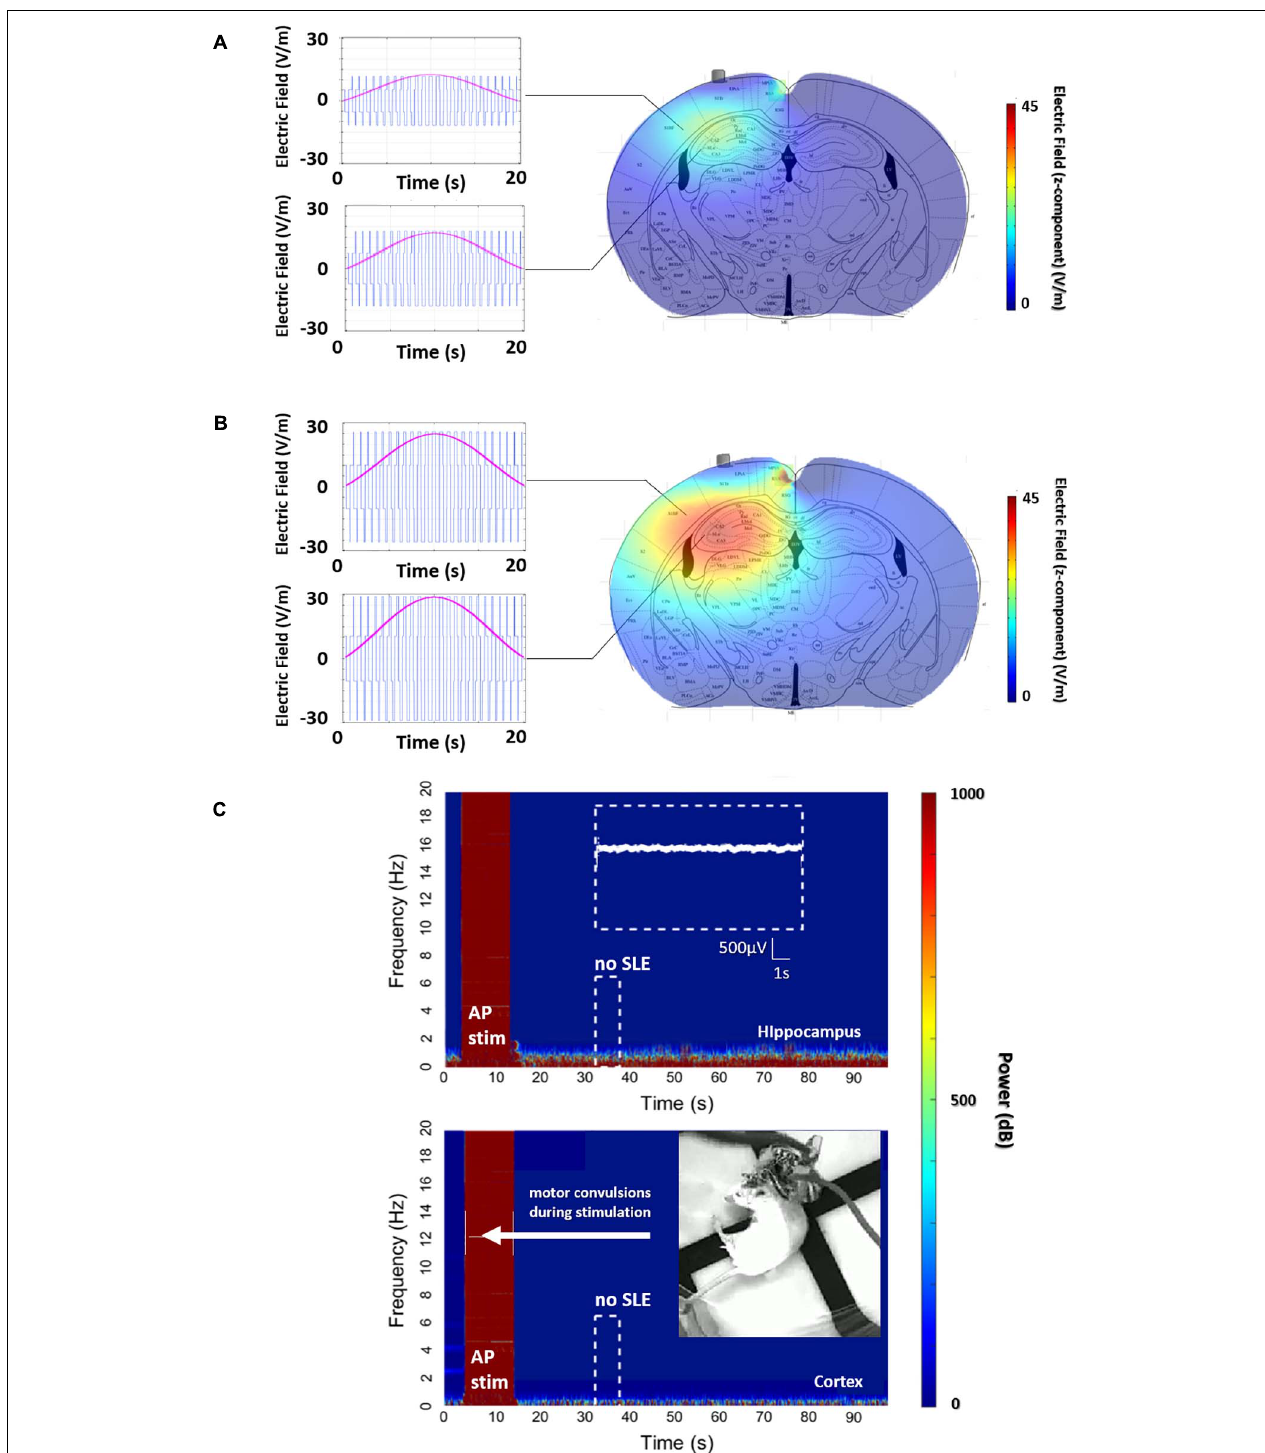
FIGURE 3 | AP, non-preferential orientation, electric field envelope versus anatomy. (A) Profile of the electric field and envelope for the stimulation in Figure 2D (600 µ A per pair), and (B) stimulation with the same orientation but with a higher stimulation amplitude (1500 µ A per pair). Clearly, continuously increasing the intensity of stimulation will increase the envelope of stimulation in the hippocampus, ideally leading to an SLE. However, the increase in stimulation amplitude creates a non-trivial increase of the envelope located in the cortex. (C) This envelope in the cortex is enough to evoke arbitrary activity and motor convulsions. As the stimulation intensity is increased for the AP orientation, significantly past the threshold for SLE in part B, single-sided motor convulsions are observed during the stimulation itself.